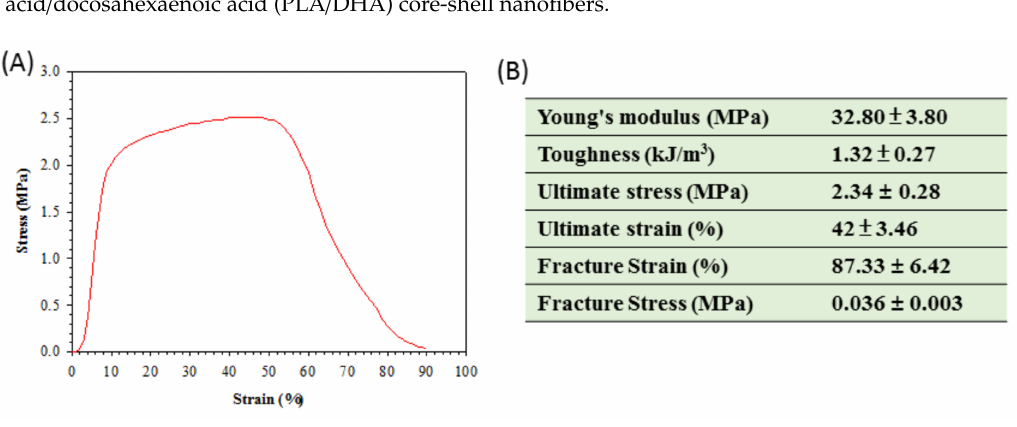
Figure 4. A typical tensile stress–strain curve of polylactic acid / docosahexaenoic acid (PLA / DHA) core-shell nanofiber membrane ( A ) and parameters of mechanical property determined from the stress-strain curves ( n = 6, mean ± SD) ( B ).